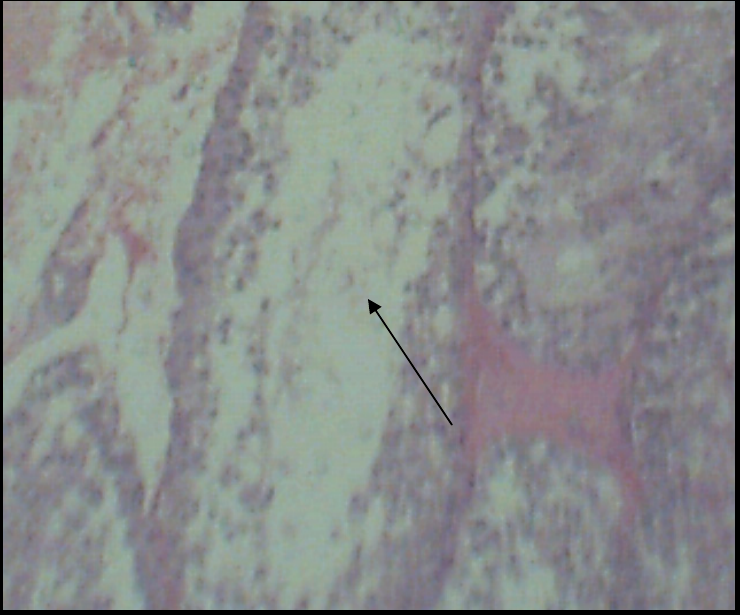
FIGURE 6 - Photomicrography of an adult hamster of the experimental group. Note the reduction in the spermatogenesis compared to control group (arrow) (HE